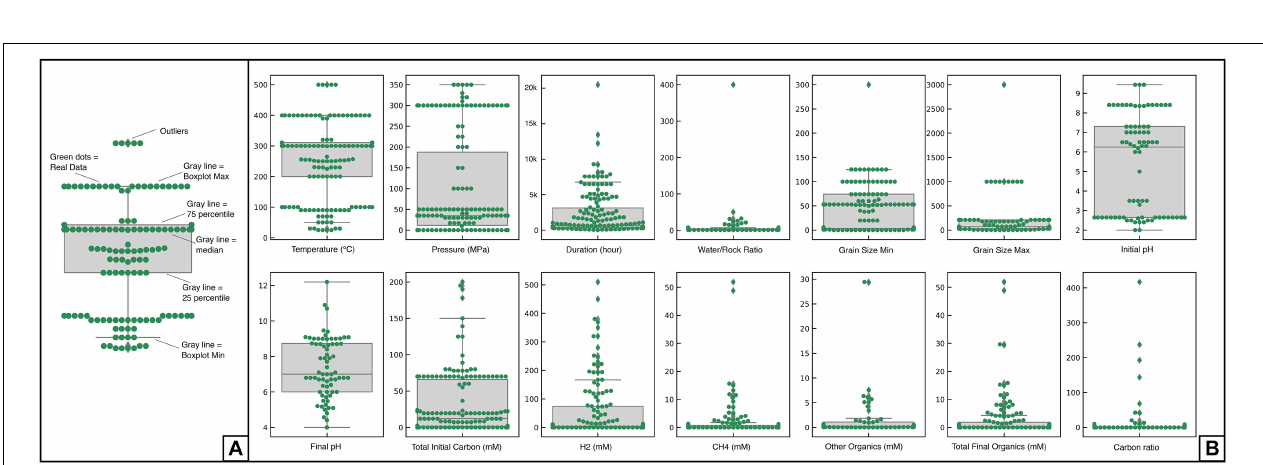
FIGURE 3 | (A) Presentation of the general attributes of a swarm plot that helps to visualize the distribution of a selected data feature (green dots), e.g., temperature, H 2 , CH 4 , and related boxplots. (B) Swarm plots of the distribution of data according to experimental parameters and results analyzed in this contribution. The x -axis indicates the parameter, and values are plotted against the y -axis.